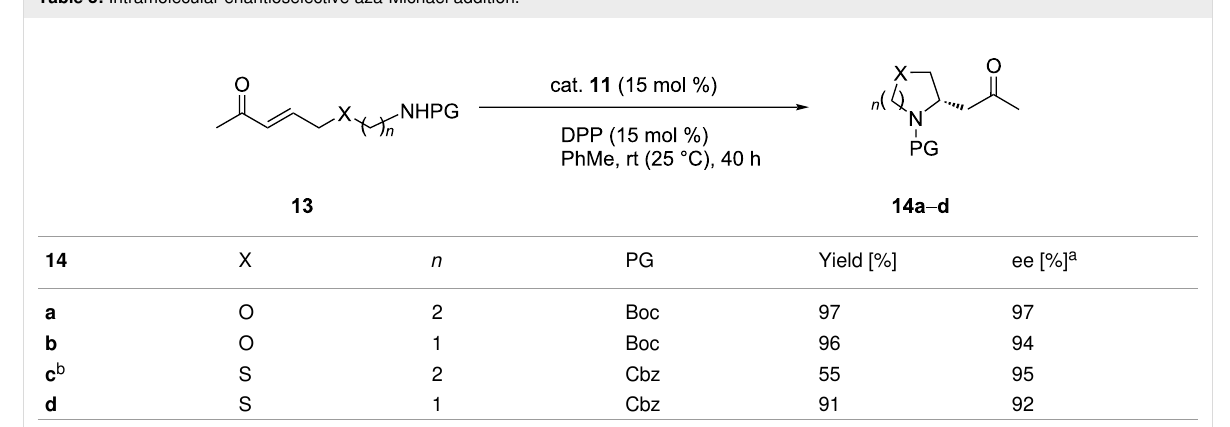
Table 3: Intramolecular enantioselective aza-Michael